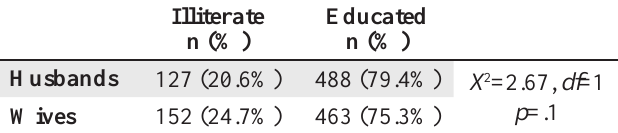
Table 1 : Literacy status of Husbands and Wives